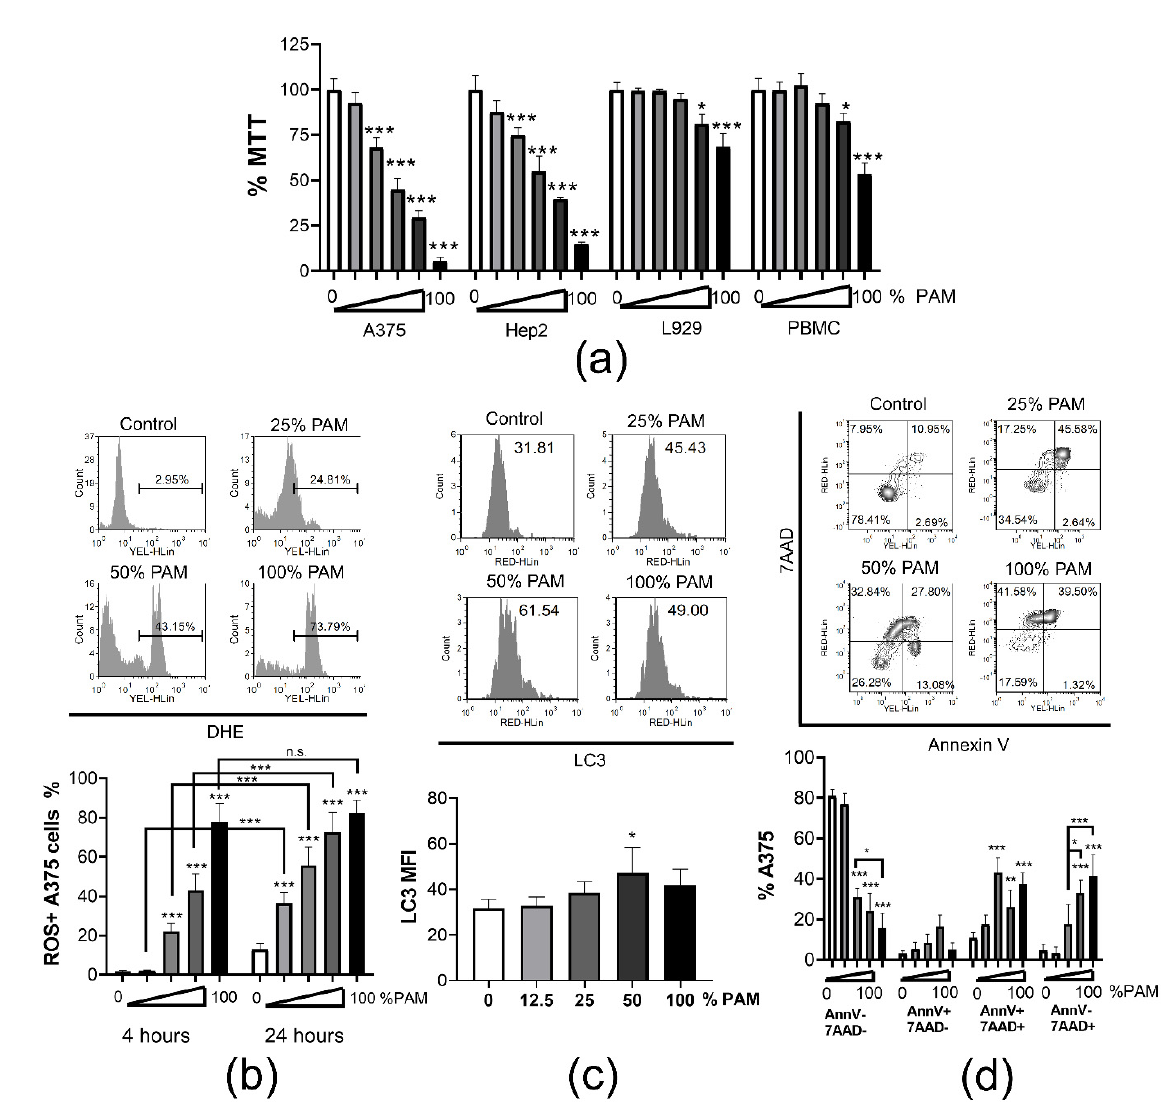
Figure 3. Dose dependent cytotoxicity of PAM. ( a ) Metabolic activity of A375, Hep2, L929, PBMC was assessed by MTT assay after 24 h treatment with serial dilutions of PAM (0% (white bars), 6%, 12.5%, 25%, 50% and 100% (black bars)) in complete RPMI medium. The results are shown as % MTT relative to the non-treated corresponding control cells 100%. Data from two independent experiments, each carried out in triplicates, are shown as the average % of MTT ± SD. ( b ) A representative data on the measurement of oxidative stress by DHE in A375 cells cultivated in the presence different concentrations of PAM for 4 h is shown. The summarized data from two independent experiments, in which the oxidative stress with the different doses of PAM (0% (white bars), 12.5%, 25%, 50% and 100% (black bars)) was measured after 4 h or 24 h as indicated, is shown as mean % of ROS+ cells ± SD. ( c ) A representative histograms on measurements of membranous LC3 expression in permeabilized A375 cells is shown with the indicated total mean fluorescence intensity (MFI), and the summarized data from two experiments is shown as MFI of LC3 ± SD. ( d ) Analysis of cell death by Annexin V/7AAD staining (AnnV − 7AAD − viable; AnnV+7AAD − early apoptosis; AnnV+7AAD+ late apoptosis; AnnV − 7AAD+ necrosis) in A375 cells is shown, carried out after 24 h cultures in presence of different doses of PAM (0%, 12.5%, 25%, 50%, 100%). Representative dot-plots and summarized data are shown as mean % A375 cells ± SD of 3 independent experiments. * p < 0.05, ** p < 0.01, *** p < 0.005 compared to non-treated control cells (0% PAM) or as indicated by line.